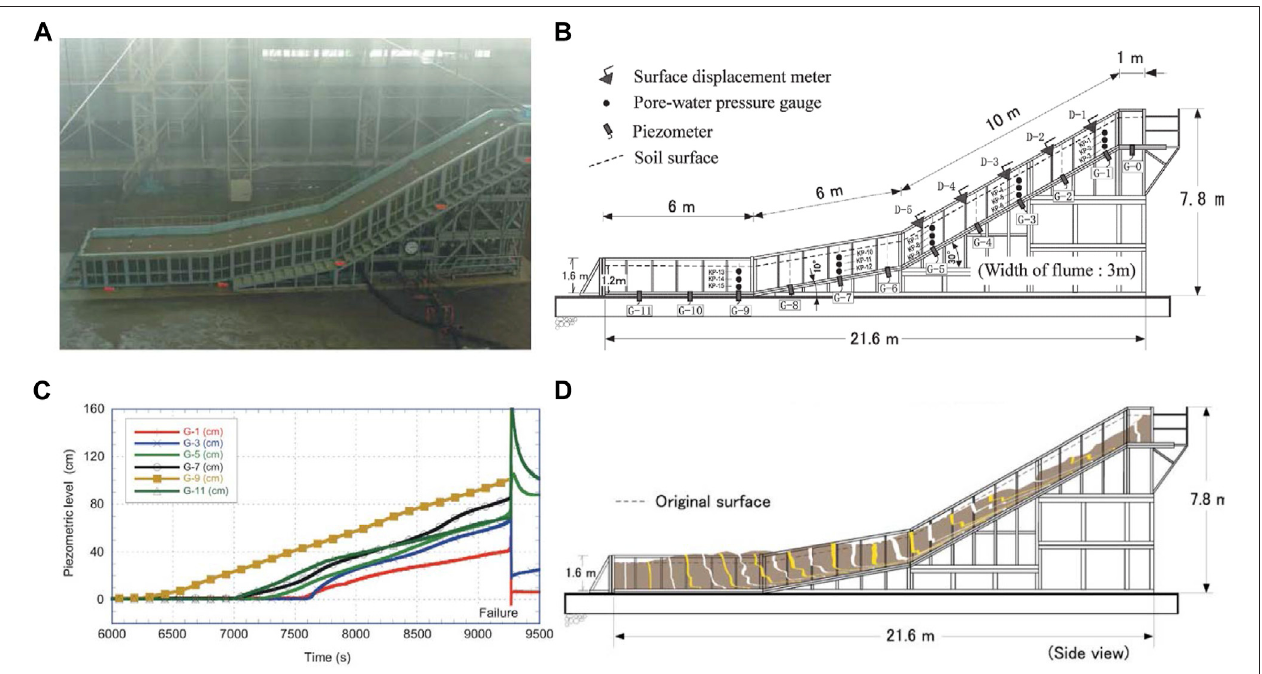
FIGURE 4 | The ofrainfall-induced slope failure experiment (Moriwaki et al., 2004): (A) Model con fi guration during the experiment; (B) The setup for the steel fl ume and the location of the sensors; (C) The piezometer record before the slope failure (D) Material deformation after the slope failure.